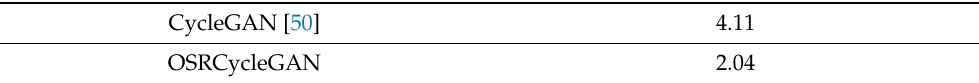
Table 15. Comparisons on memory usage by CycleGAN and proposed OSRCycleGAN (unit: Giga Bytes).